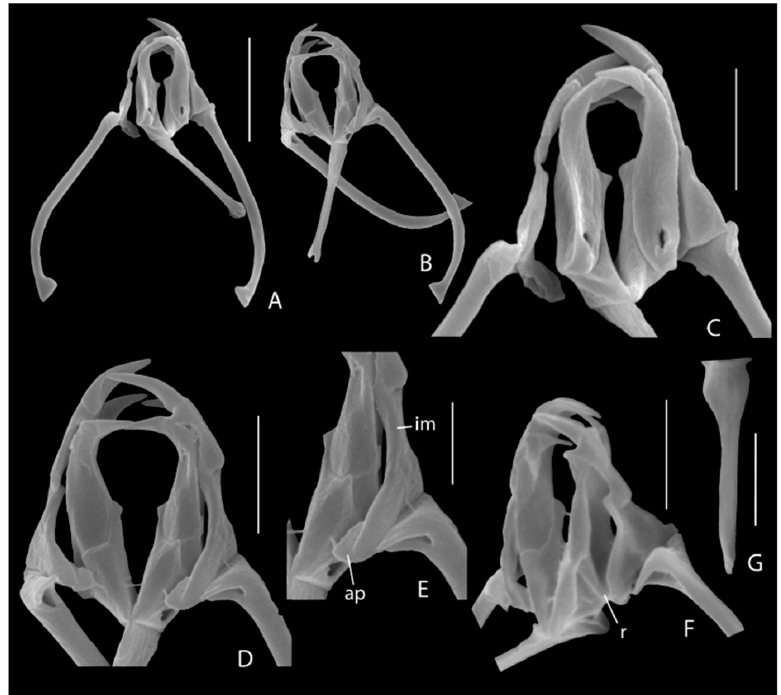
Figure 3. Encentrum melonei sp. nov., scanning electron microscopy (SEM) photographs of trophi. ( A ) Complete set, dorsal. ( B ) Complete set, ventral. ( C ) Detail, dorsal. ( D ) Detail, ventral. ( E ) Left intramalleus, ventro-lateral. ( F ) Detail, ventro-lateral. ( G ) Fulcrum, lateral. ap: additional platelet; im: intramalleus; r: ridge between subbasal and basal chamber. Scale bars: ( A , B ): 10 µm; ( C − G ): 5 µm.